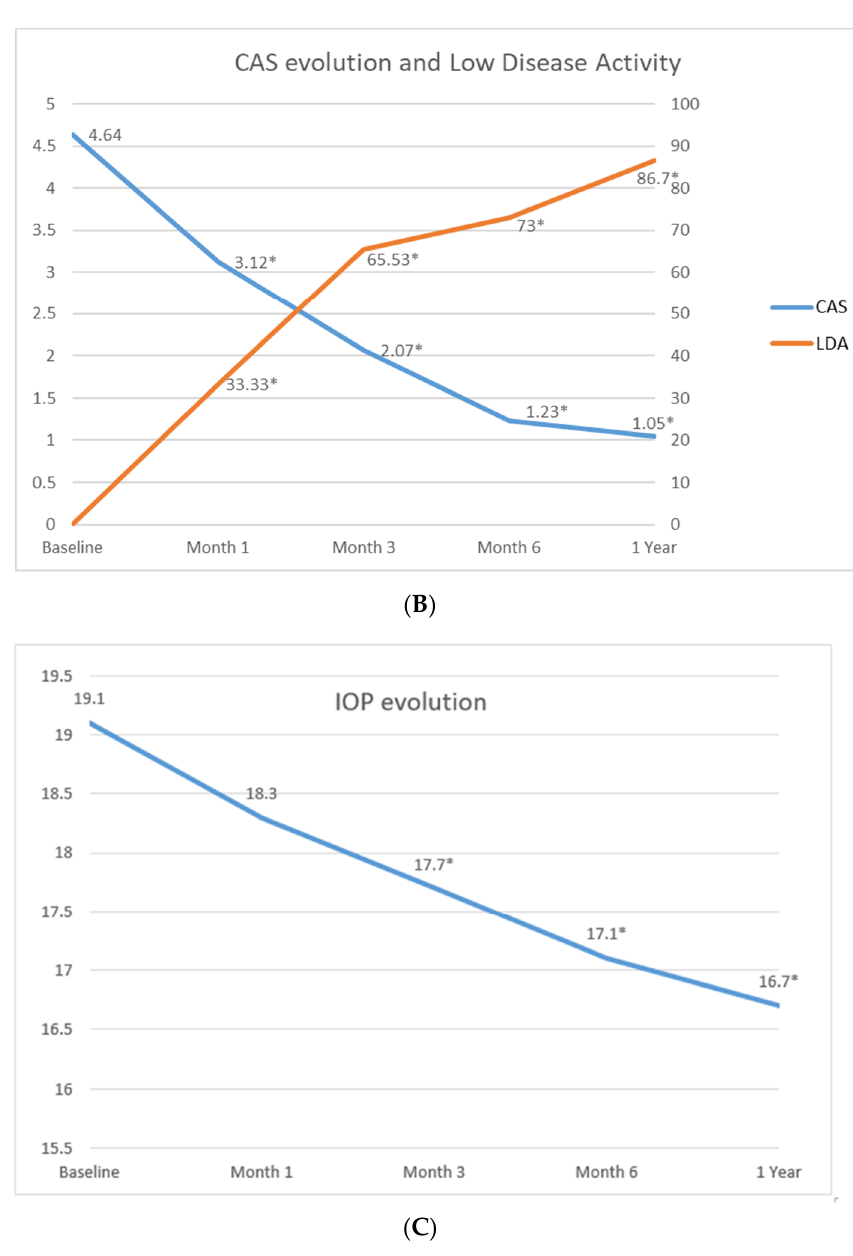
Figure 1. Improvement of the main ocular parameters with TCZ therapy. ( A ) Best-corrected visual acuity (BVCA); ( B ) Clinical Activity Score; (CAS) evolution and Low Disease Activity (LDA); ( C ) Intraocular pressure (IOP) evolution. Data are expressed as mean ± SD or median (IQR). * p < 0.05 compared with baseline .